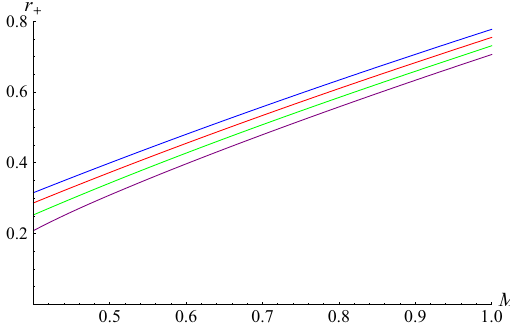
l = m 2 cc 1 = m 2 c 2 c 2 = 1. The blue, red, green and purple curves correspond to k = 0 . 1 , 0 . 15 , 0 . 2, 0.25, respectively